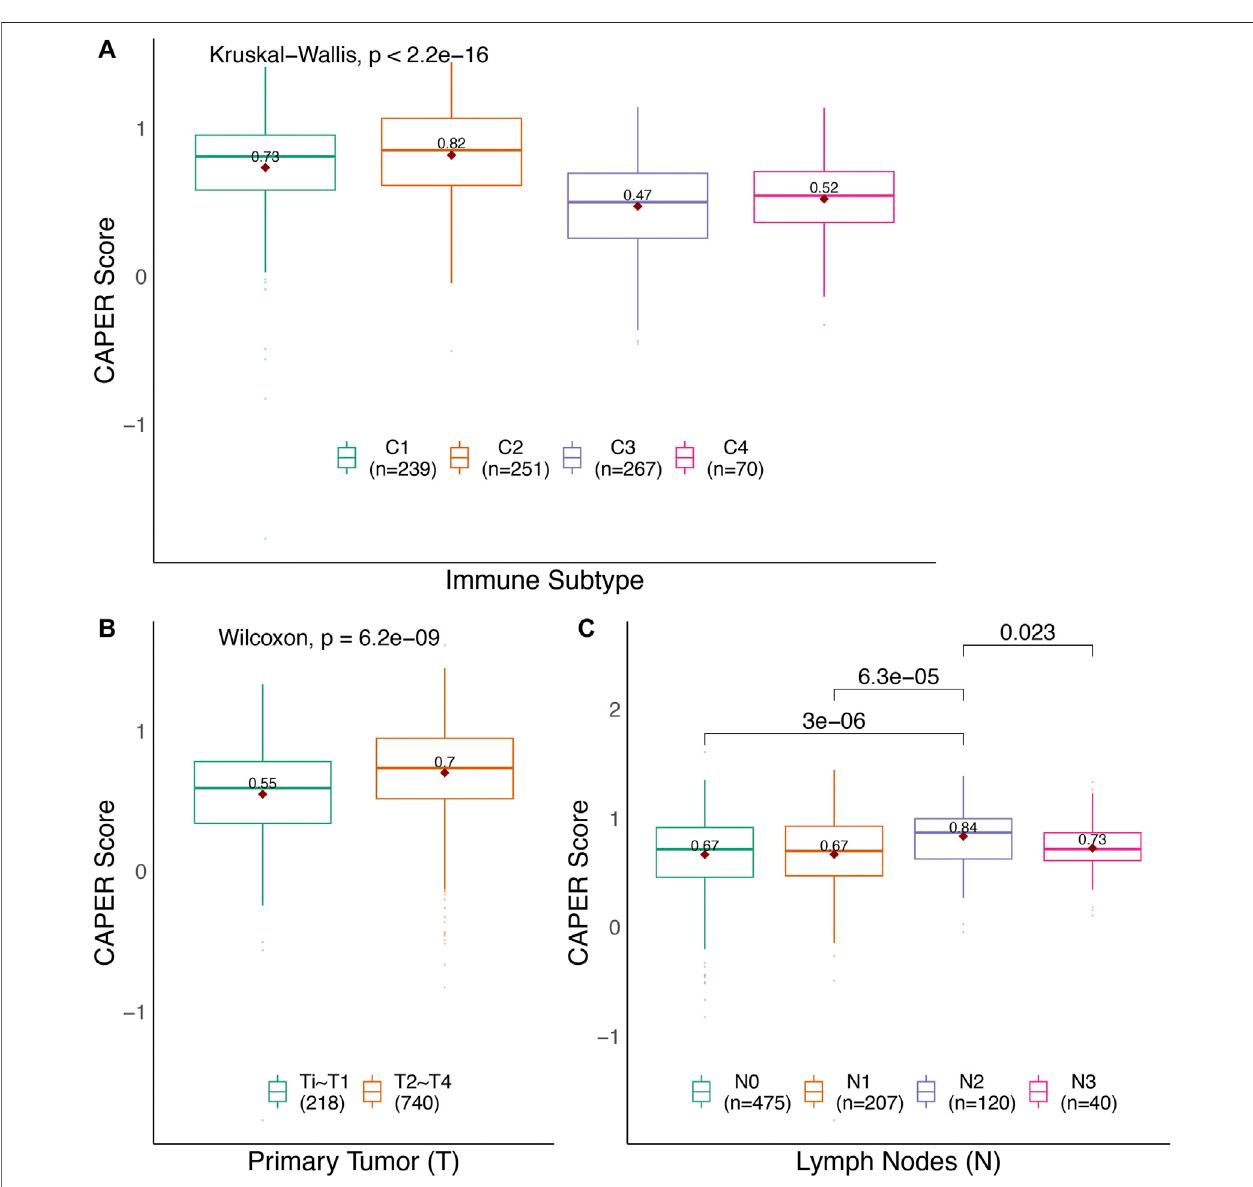
FIGURE 4 | Summary of the differences between the three tumor-related variables in the different CAPER groups using the TCGA test set. (A) immune subtypes; (B) the pathological stage of the primary tumor (T); (C) the pathological stage of the lymph nodes (N).